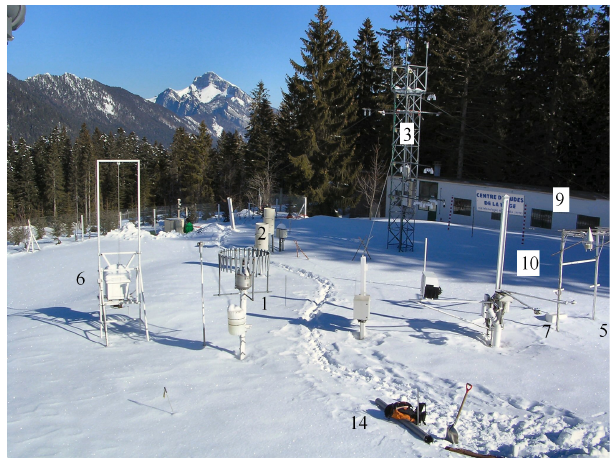
Figure 2. Overview of the experimental site in the middle of the snow season (view towards the North). The numbering is similar to Fig. 1.